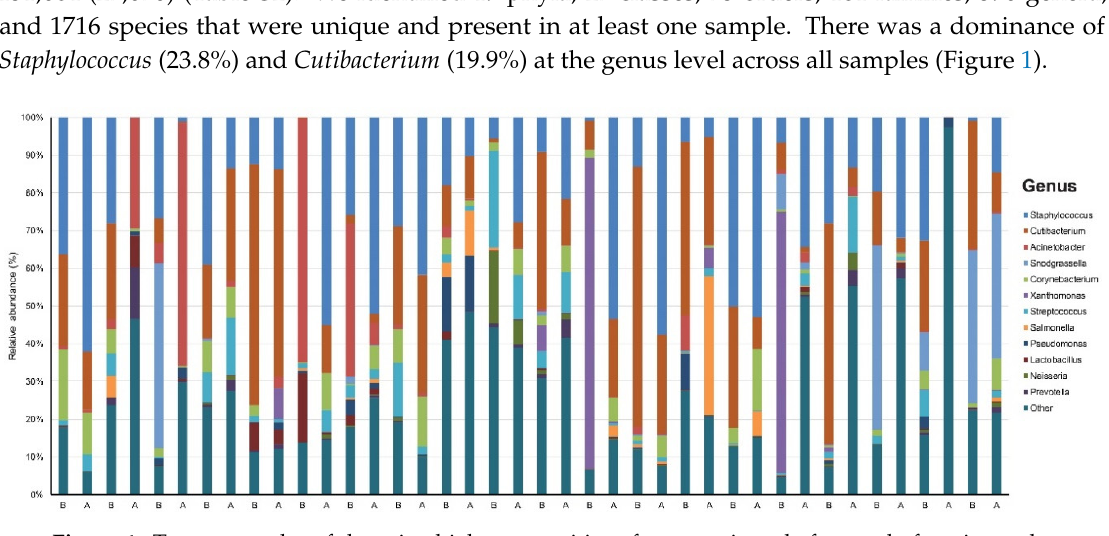
Figure 1. Taxonomy plot of the microbial communities of acne patients before and after six weeks of doxycycline.